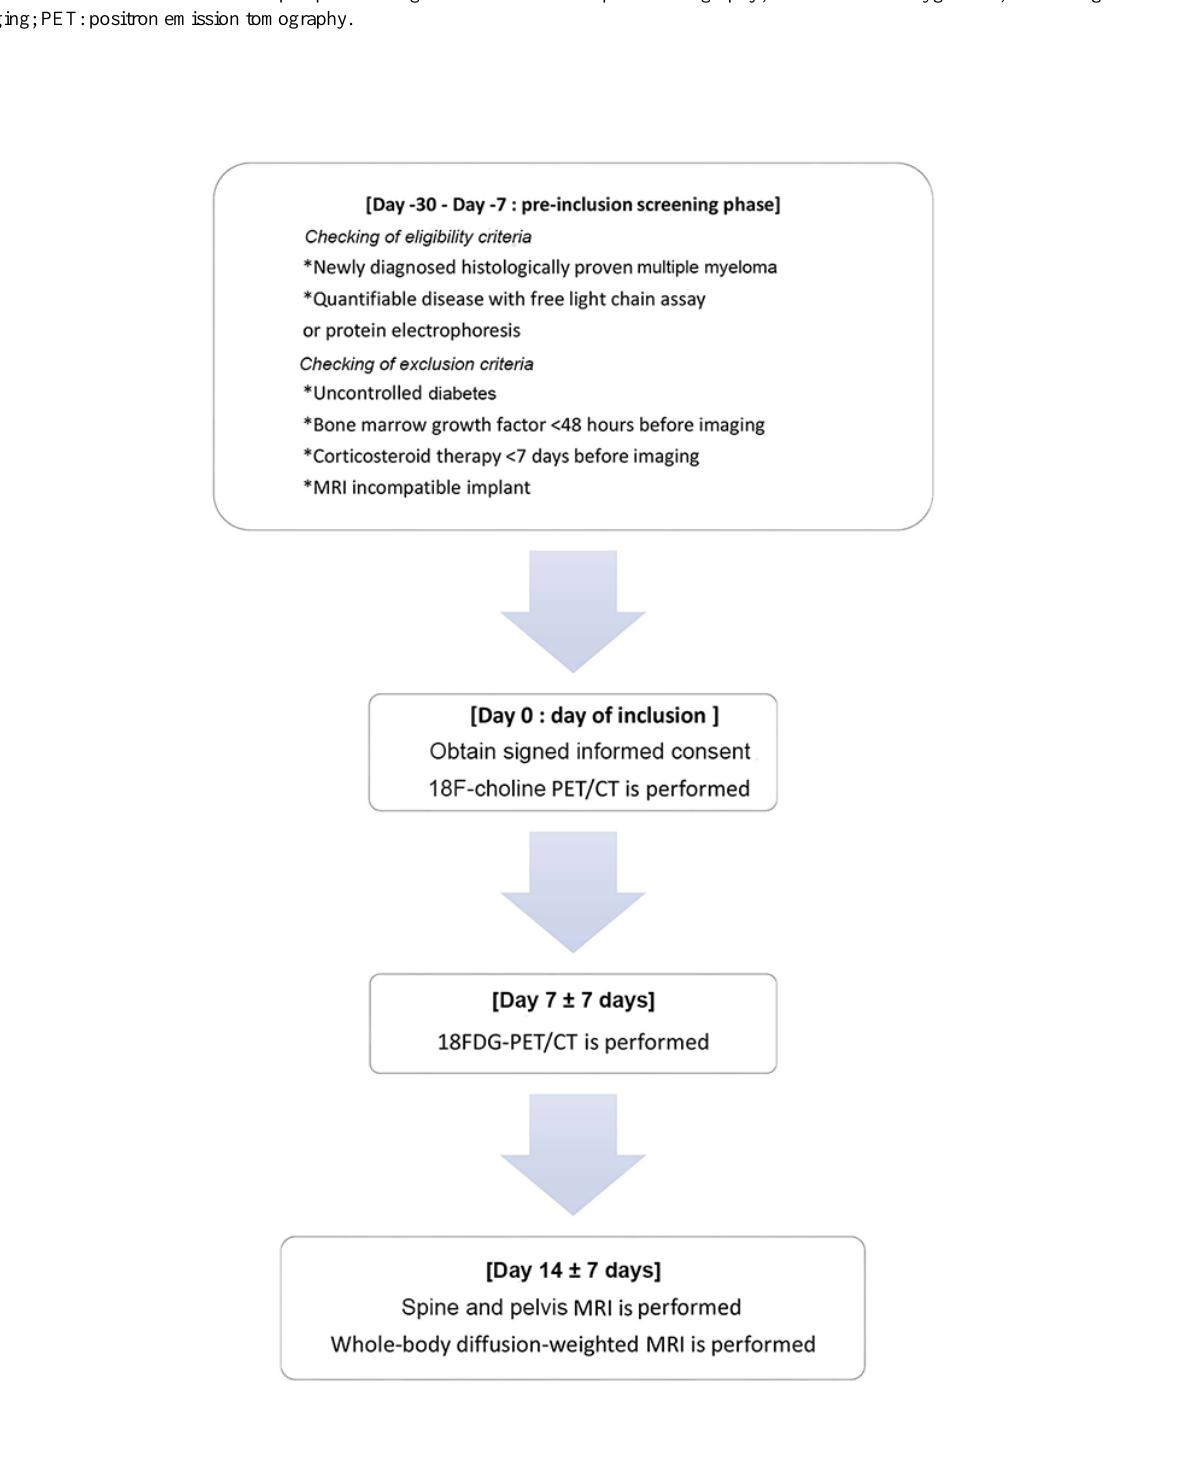
Figure 1. Flowchart of the current prospective diagnostic trial. CT: computed tomography; FDG: fluorodeoxyglucose; MRI: magnetic resonance imaging; PET: positron emission